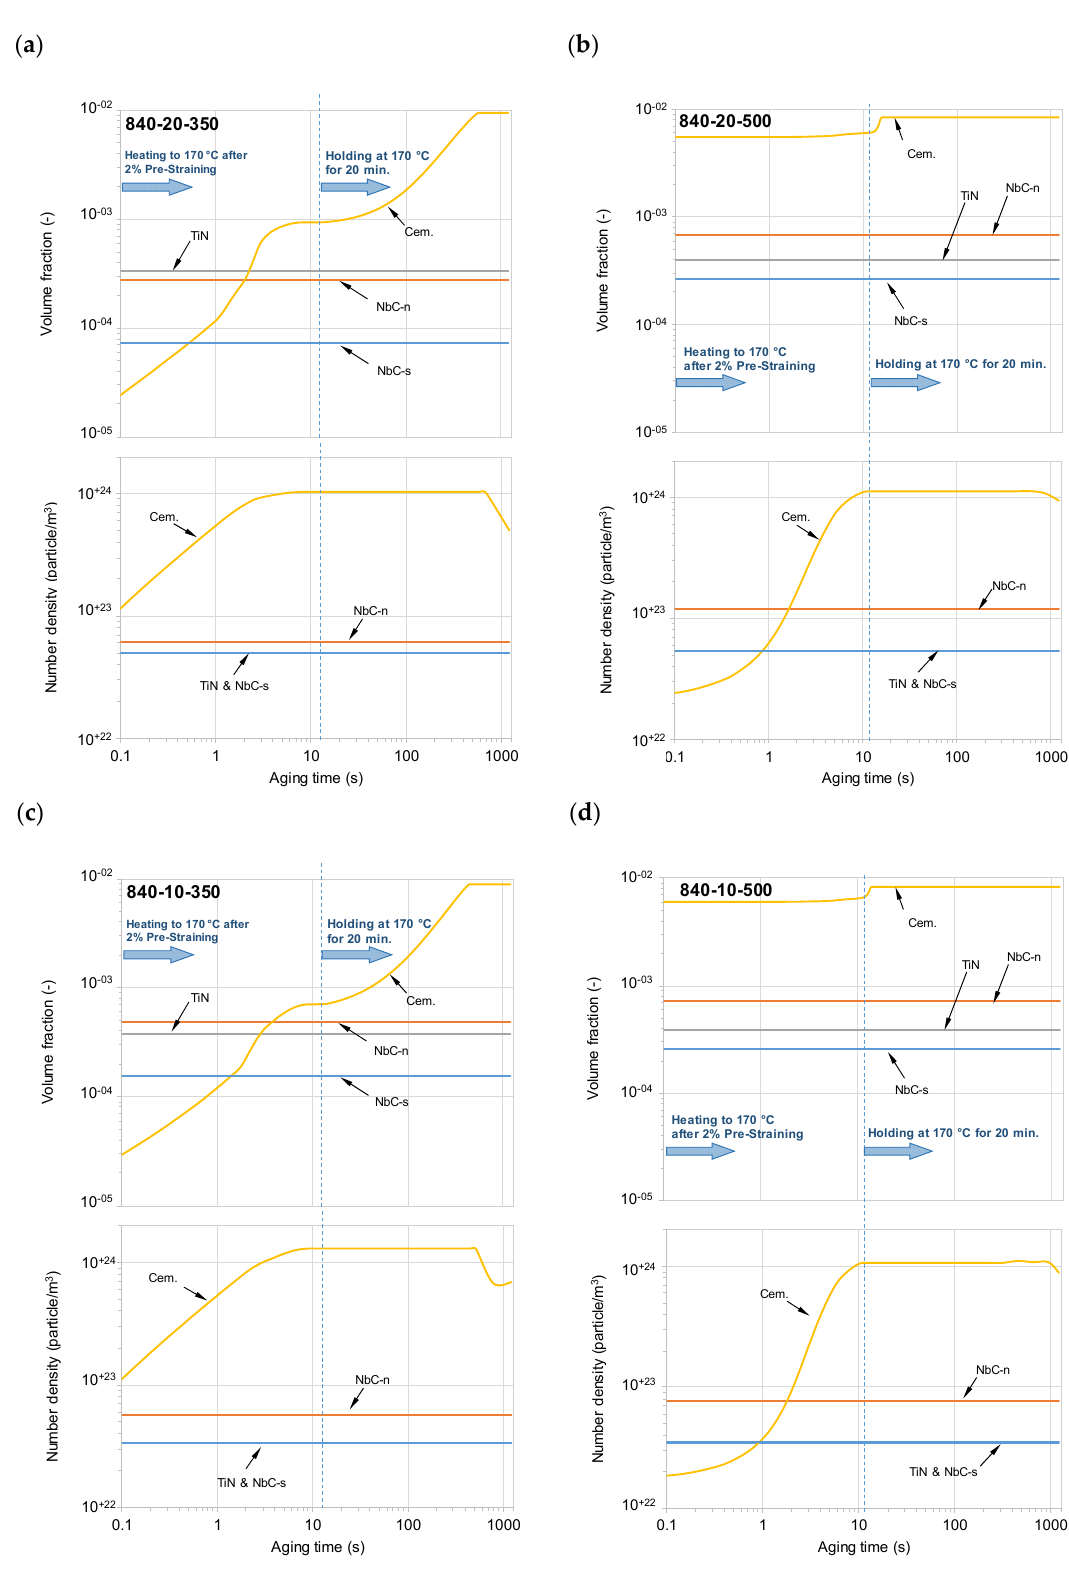
Figure 14. Precipitation kinetics during aging at 170 ◦ C after 2% pre-straining, predicted using the software MatCalc ® . The steel is thermo-mechanically processed prior to strain aging by applying FRT = 840 ◦ C and the “a-CT” parameters of ( a ) 20 K · s − 1 -350 ◦ C, ( b ) 20 K · s − 1 -500 ◦ C, ( c ) 10 K · s − 1 -350 ◦ C and ( d ) 10 K · s − 1 -500 ◦